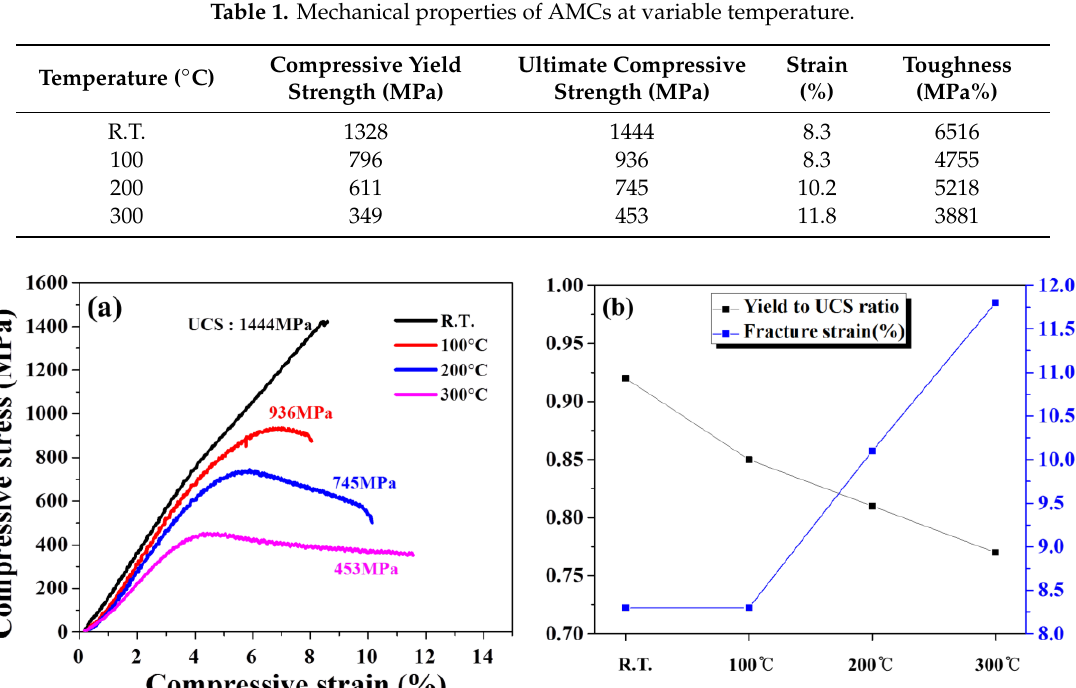
Figure 2. ( a ) Compressive properties, and ( b ) yield to UCS (ultimate compressive strength) ratio of the bimodal B 4 C/Al7075 AMCs at room temperature and elevated temperatures.